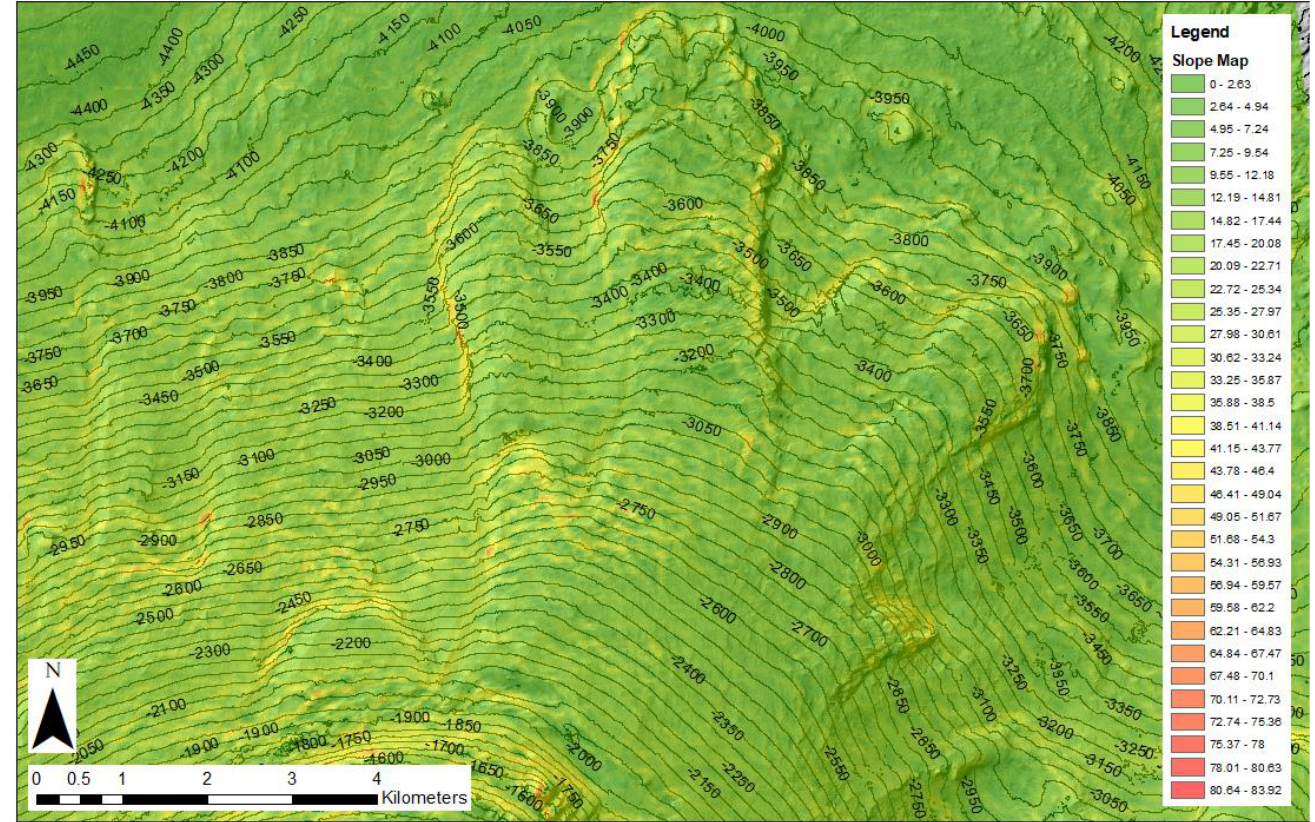
Figure 10. CTX DEM-derived Slope Map with contour 50 m interval. Slope map and contour created from CTX DEM. Image covers 6 of the 10 lobes reviewed in this study due to higher preservation states. Image derived from HiRISE images ESP_018788_1755, slope map created in ArcGIS 10.8.1 using CTX DEM derived from CTX stereo pairs P01_001422_1747_XN_05S222W and P18_008002_1748_XN_05S222W. Image: NASA/JPL-Caltech/MSSS; DTM: NASA/JPL- Caltech/MSSS/NHM; the stereo DTM processing was carried out at the Natural History Museum, London; slope and contour overlay map: Williams